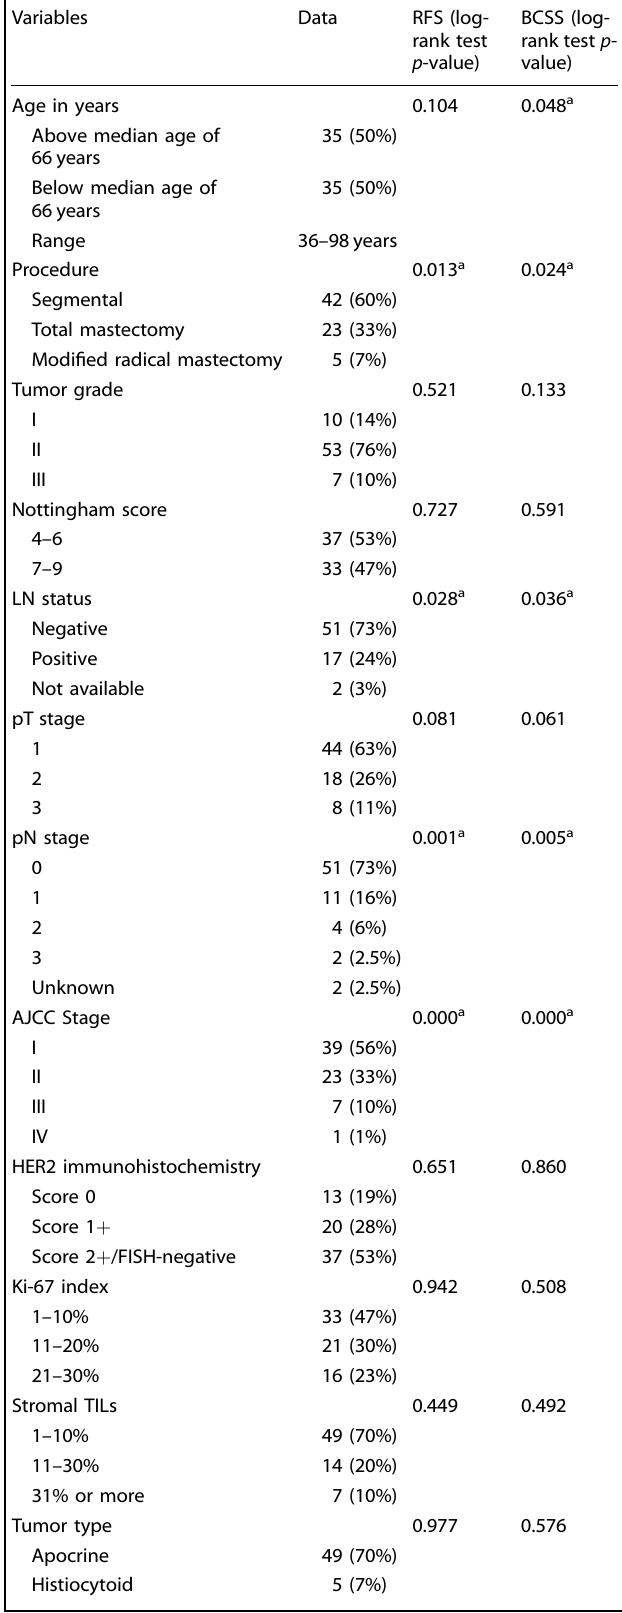
Table 2. Survival assessed by Kaplan – Meier survival analysis using log-rank test for each